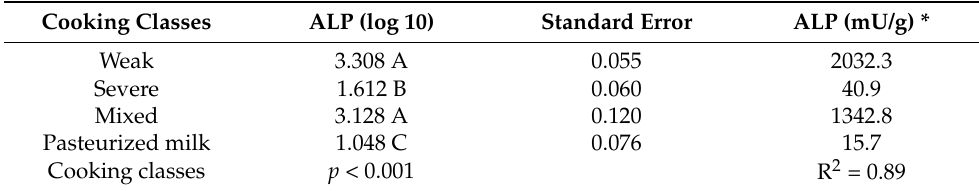
Table 4. Least square means (LSM) of ALP logarithmic